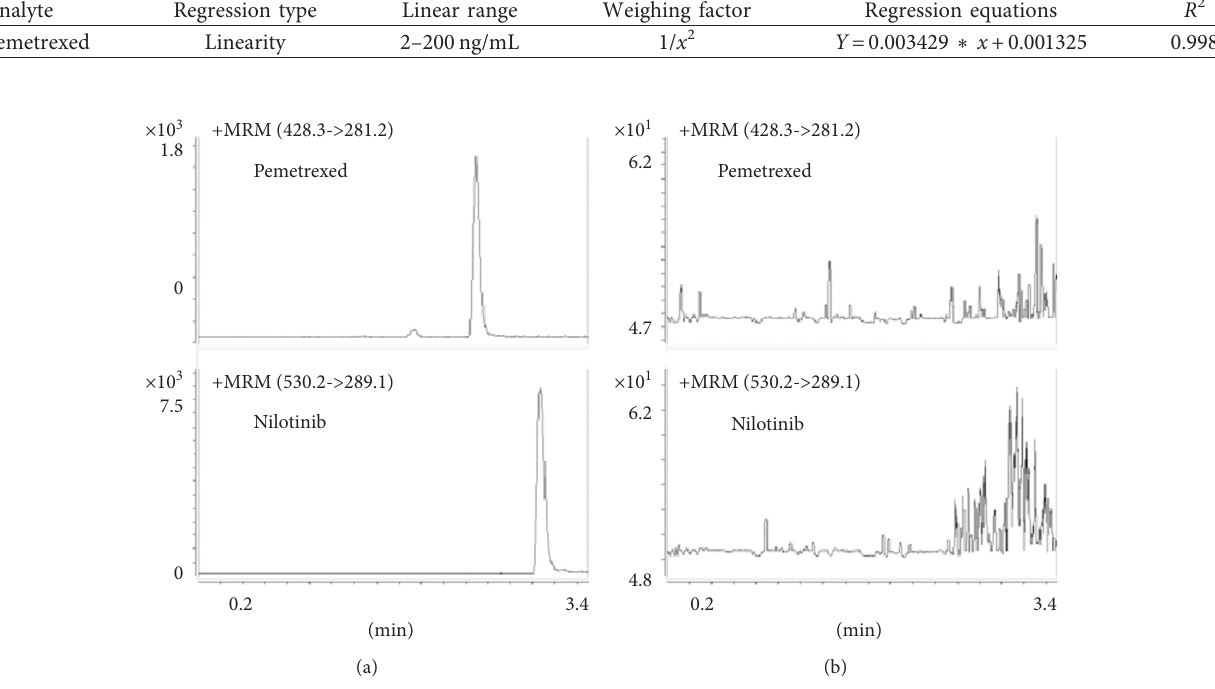
Figure 3: The results of carryover of pemetrexed. (a) Highest calibration standard sample and (b) following blank sample. Table 3: Interprecision and intraprecision and accuracy of pemetrexed ( n �